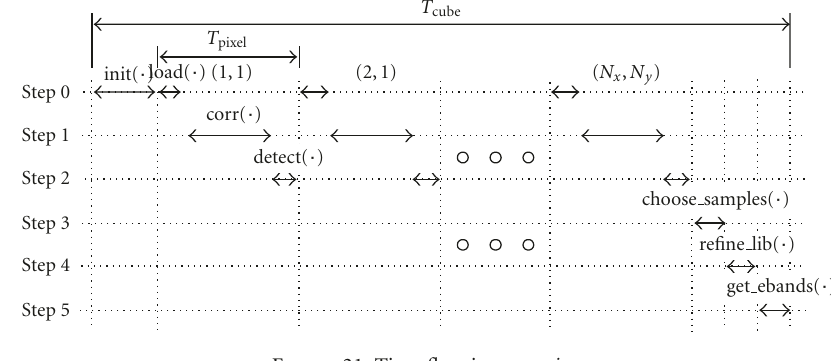
Figure 21: Time flow in processing .